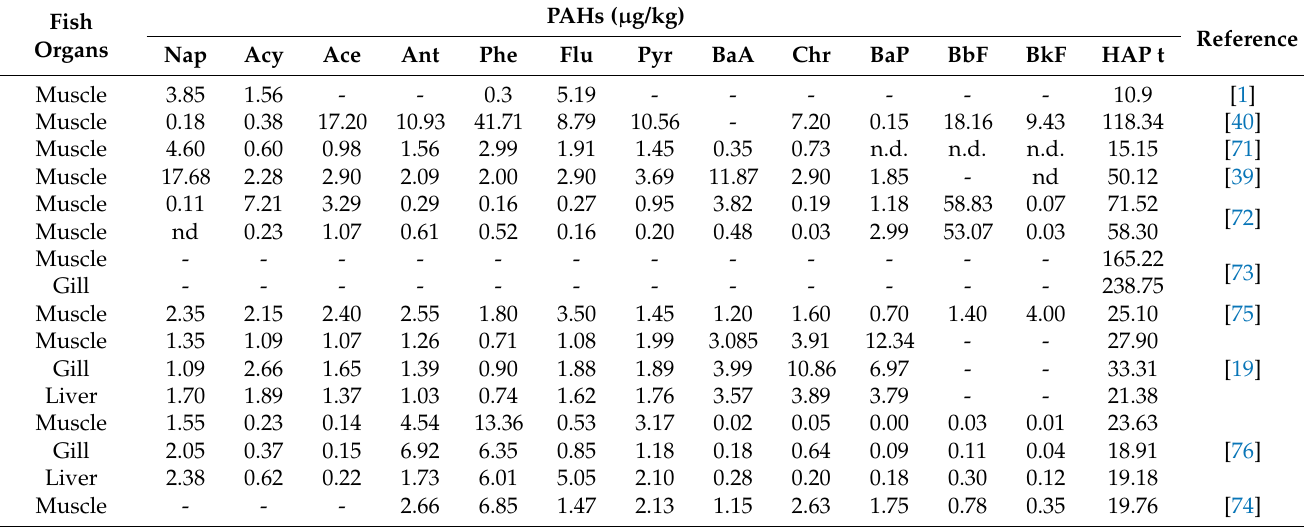
Table 7. Comparison of the concentrations of the present study with those of the